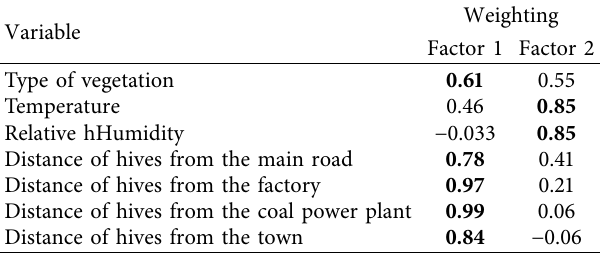
Table 3: Contribution of different environmental variables to the two factor scores in the PCA